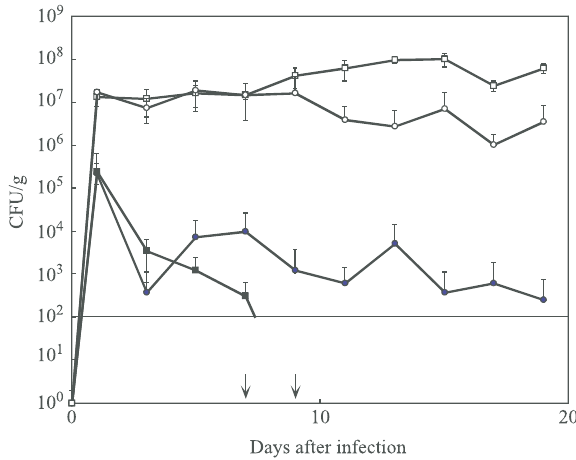
FIG. 1. Viable Candida cells in feces of C. albicans-infected mice treated with prednisolone. BALB/c mice were given potable water with (open symbols) and without antibiotic (closed symbols). Mice were infected with 10 6 CFU of C. albicans in their intestinal tracts, then were subcutaneously given 100 mg/kg of prednisolone (closed squares, open squares) or saline (closed circles, open circles) at 7 and 9 days after this infection, respectively. Feces counts were determined at time points thereafter. The results are ex- pressed as a viable count obtained from groups of nine mice per data point.